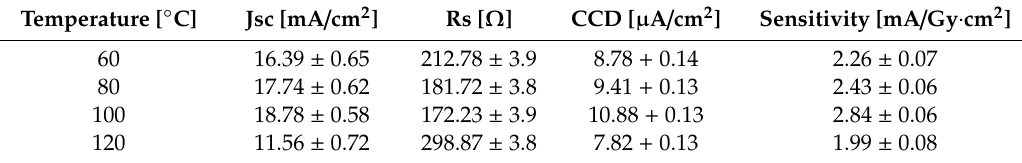
Table 1. J SC , R S , CCD and sensitivity of the detector based on 192 nm thick MAPbI 3 layer at various annealing